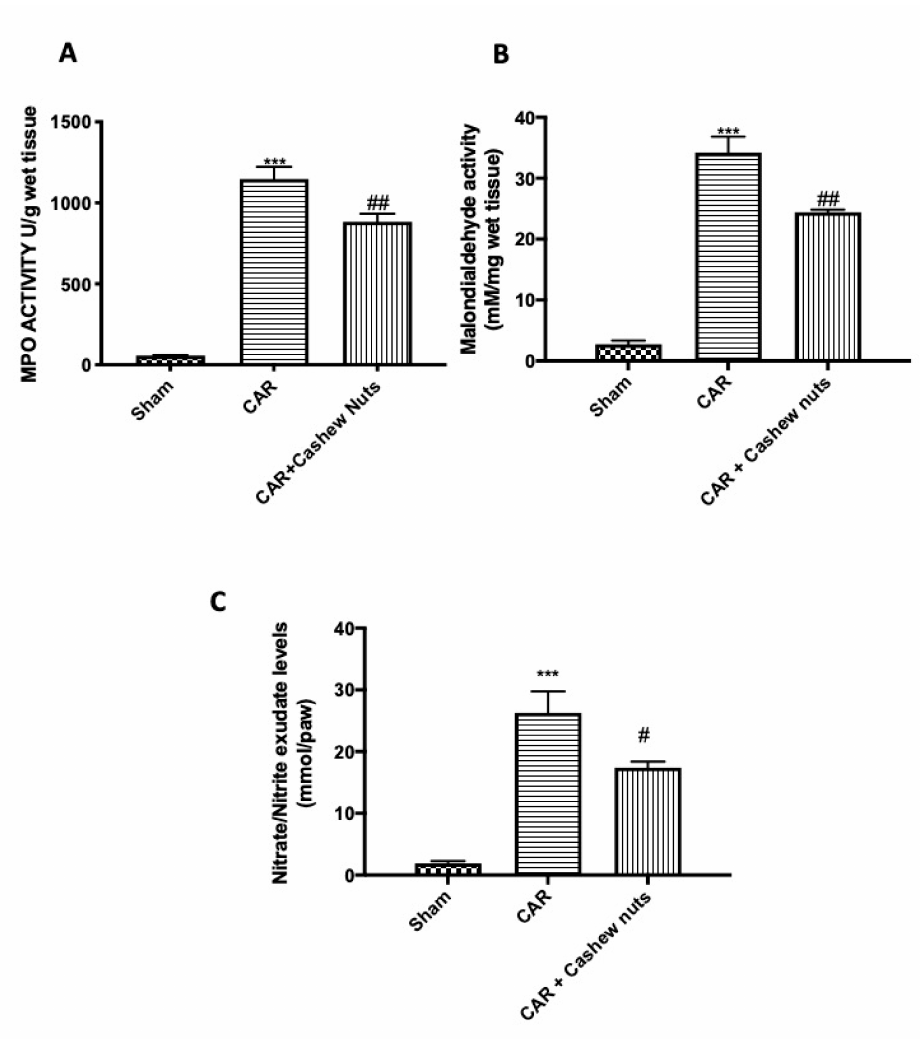
Figure 3. E ff ects of cashew nuts on nitrate / nitrite, MPO, and MDA activity after CAR-injection. As a consequence of neutrophils infiltration and lipid peroxidation MPO and MDA were assessed. Additionally, considering the key role played by NO during inflammatory events, we analyzed also levels in nitrite / nitrate in paw exudate. Carrageenan induces a significant increase in all parameter taken in consideration. On the other hands, oral treatment with cashew nuts at the dose of 100 mg / kg significantly reduced MPO, MDA, and nitrate / nitrite CAR-induction. MPO ( A ); MDA ( B ); nitrate / nitrite ( C ). See materials and methods for further details. # p < 0.05 vs. CAR; ## p < 0.01 vs. CAR; *** p < 0.001 vs.